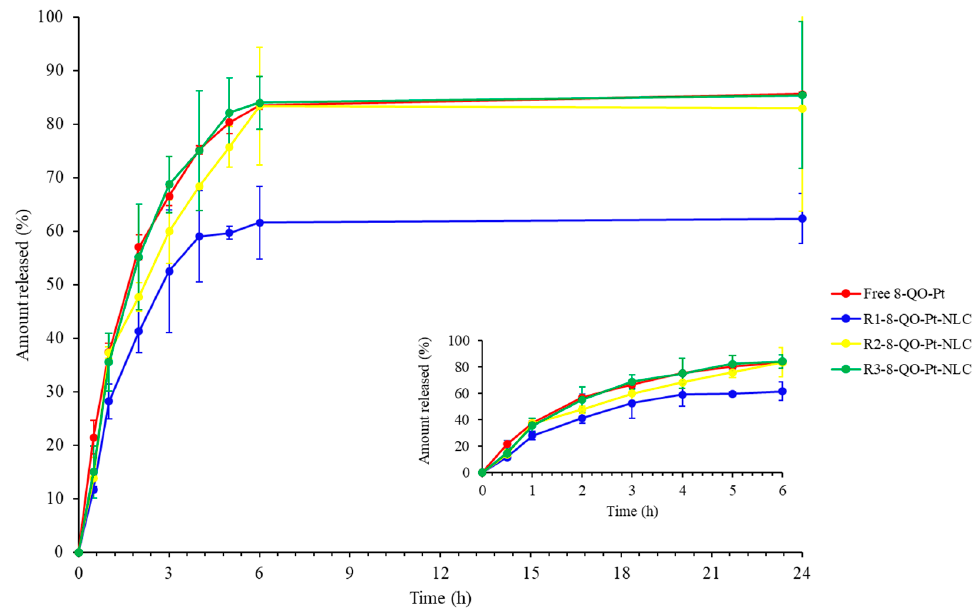
Figure 2. Release profiles (mean ± SD) of free 8-QO-Pt (red), R 1 -8-QO-Pt-NLC (blue), R 2 -8-QO-Pt- NLC (yellow), and R 3 -8-QO-Pt-NLC (green) for 24 h.